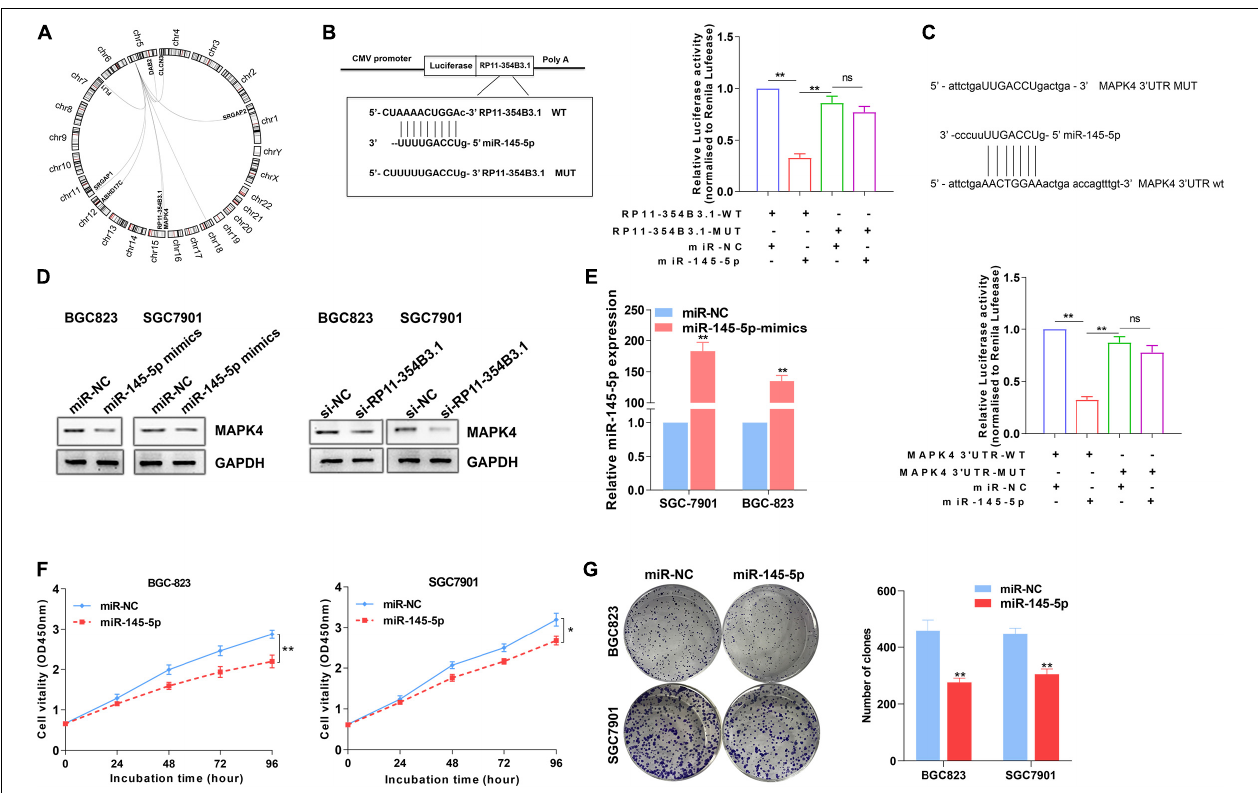
FIGURE 5 | Regulation relationship between RP11-354B3.1, miR-145-5p, and MAPK4. (A) RP11-354B3.1-miR-145-5p-targets ceRNA network. (B) Schematic view of miR-145-5p putative targeting site in the WT and Mut 3 (cid:48) UTR of MAPK4 (Left). The luciferase reporter plasmid containing wild type (WT) or mutant (Mut) RP11-354B3.1 was co-transfected with miR-145-5p in parallel with an empty plasmid vector (Right). (C) Schematic view of miR-145-5p putative targeting site in the WT and Mut 3 (cid:48) UTR of MAPK4 (Up). Luciferase activity assay transfected with luciferase report plasmids containing MAPK4 3 (cid:48) UTR (WT or Mut) with control miRNA or miR-145-5p (Down). (D) Relative protein levels of MAPK4 in SGC7901 and BGC823 cells transfected with miR-145-5p-mimics or siRNA of RP11-354B3.1. (E) miR-145-5p level in SGC7901 and BGC823 cells following overexpression of miR-145-5p. (F) Growth curves show the proliferation ability of miR-145-5p mimics treated SGC7901 and BGC823 cells. (G) Colony formation assays were used to evaluate the colony formation capacity of miR-145-5p mimics treated SGC7901 and BGC823 cells. All experiments were performed in three independent replicates. * P < 0.05; ** P <